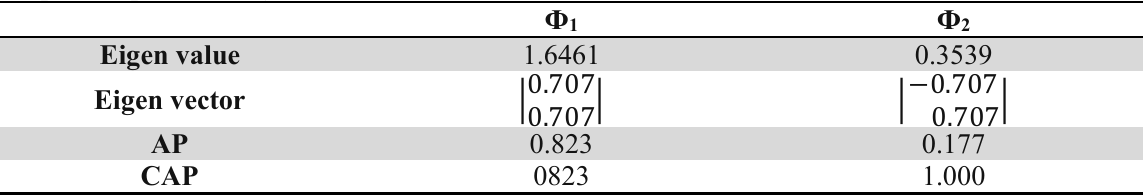
Principal component